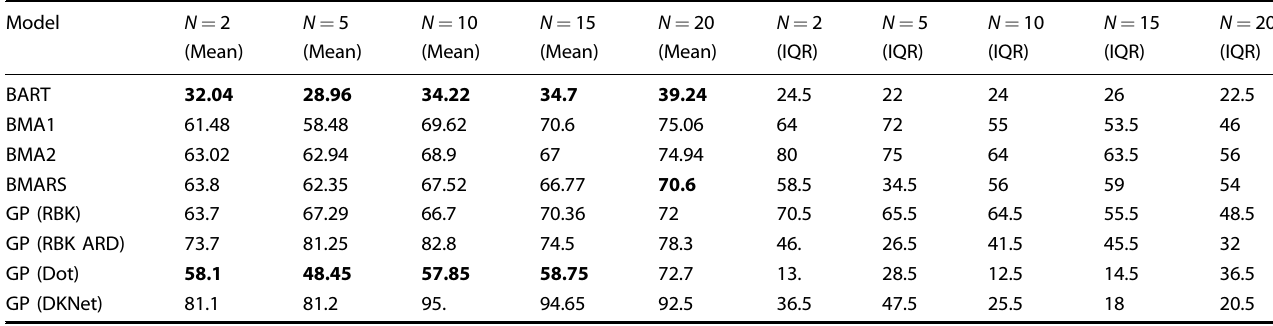
The bold values correspond to the top two models in terms of search performance.